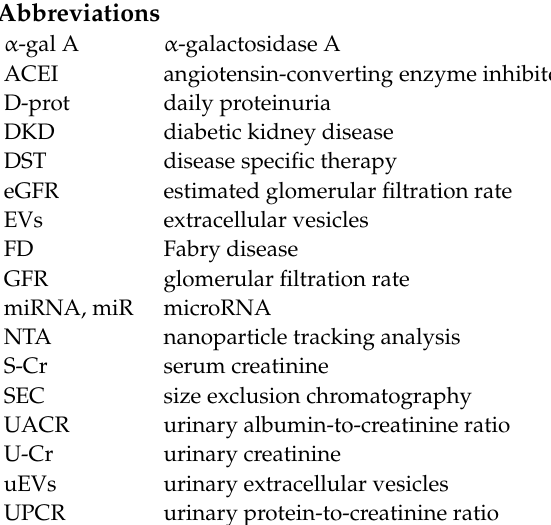
clinical parameters in FD patients without nephropathy ( n = 9), Table S2: Spearman’s correlation analysis of uEVs characteristics and clinical parameters in FD patients with nephropathy ( n = 10), Table S3: Medians of concentration, mean, modal, and median diameter in patients (a) without ( n = 8) and (b) with Fabry nephropathy ( n = 10) in 5-year period, Table S4: Medians of concentration, mean, modal, and median diameter in patients (a) without ( n = 6) and (b) with Fabry nephropathy ( n = 8) in 10-year period, Table S5: Spearman’s correlation analysis between expression of miRNAs and clinical parameters in FD patients without nephropathy ( n = 9), Table S6: Spearman’s correlation analysis between expression of miRNAs and clinical parameters in FD patients with nephropathy ( n =